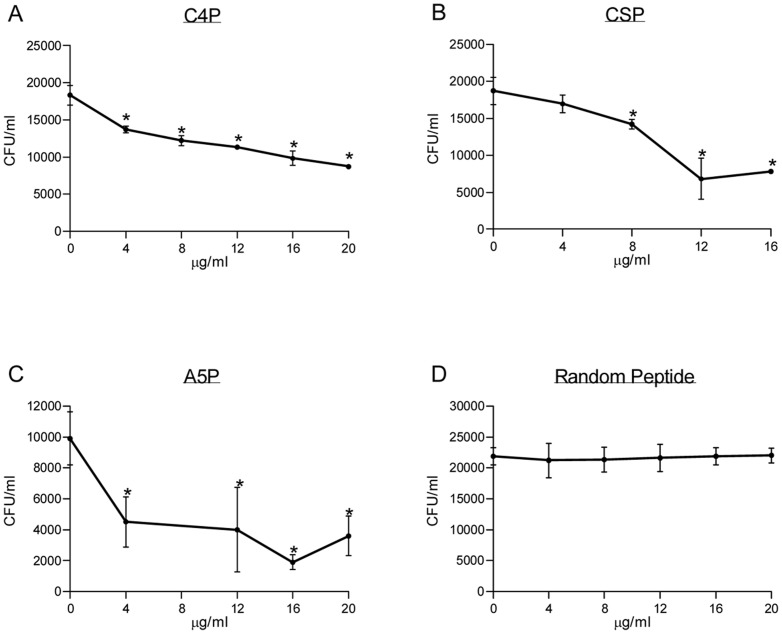
Inhibition of S. pneumoniae adhesion to A549 cells by NOX target peptides.
S. pneumoniae serotype 3 strain WU2 was incubated for 60 min. with the corresponding peptide at the denoted concentration. The bacteria/peptide suspension was added to the cultured A549 cells for 60 minutes incubation. Following incubation, excess peptide/bacteria suspension was removed, and the cells were detached and plated onto blood agar plates for bacterial enumeration. A significant dose-dependent inhibition of bacterial adhesion was observed in Spearman regression analysis. A. Contactin 4 derived peptide (C4P, r = −0.889, t' test p<0.05), B. Chondroitin 4 Sulfotransferase derived peptide (CSP, r = −0.705, t' test p<0.05). C. Alpha 5 Laminin (A5P, r = −0.643, t' test p>0.05).